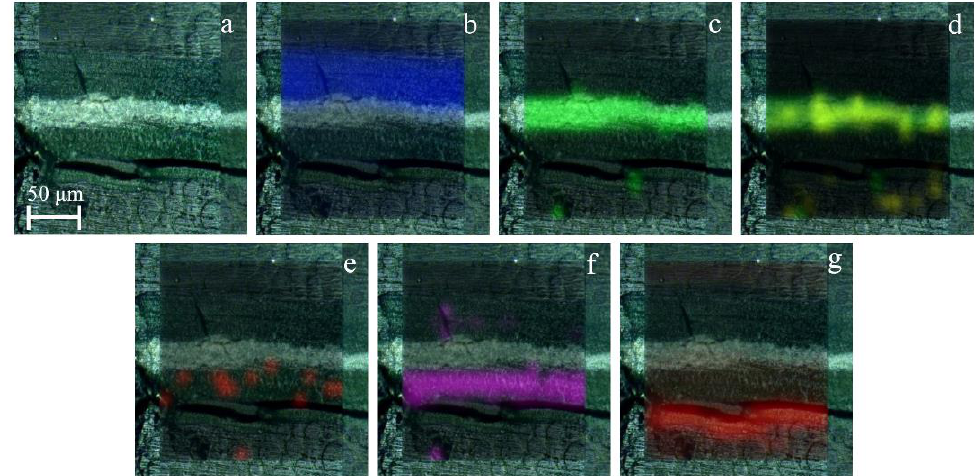
Figure 3. Optical image ( a ) and Raman spectroscopy image of the sample in section showing its molecular composition: phthalocyanine green ( b ), rutile ( c ) and calcium carbonate ( d ), barium sulfate ( e ), Prussian blue ( f ), and phthalocyanine blue ( g ). The black line through the sample is a crack in the sample.